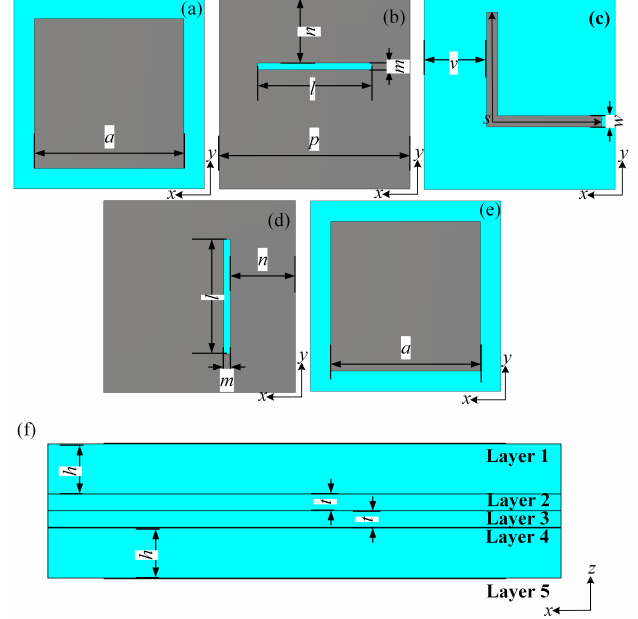
Figure 1. Geometry of the unit cell: ( a ) Layer-1. ( b ) Layer-2. ( c ) Layer-3. ( d ) Layer-4. ( e ) Layer-5. ( f ) Side